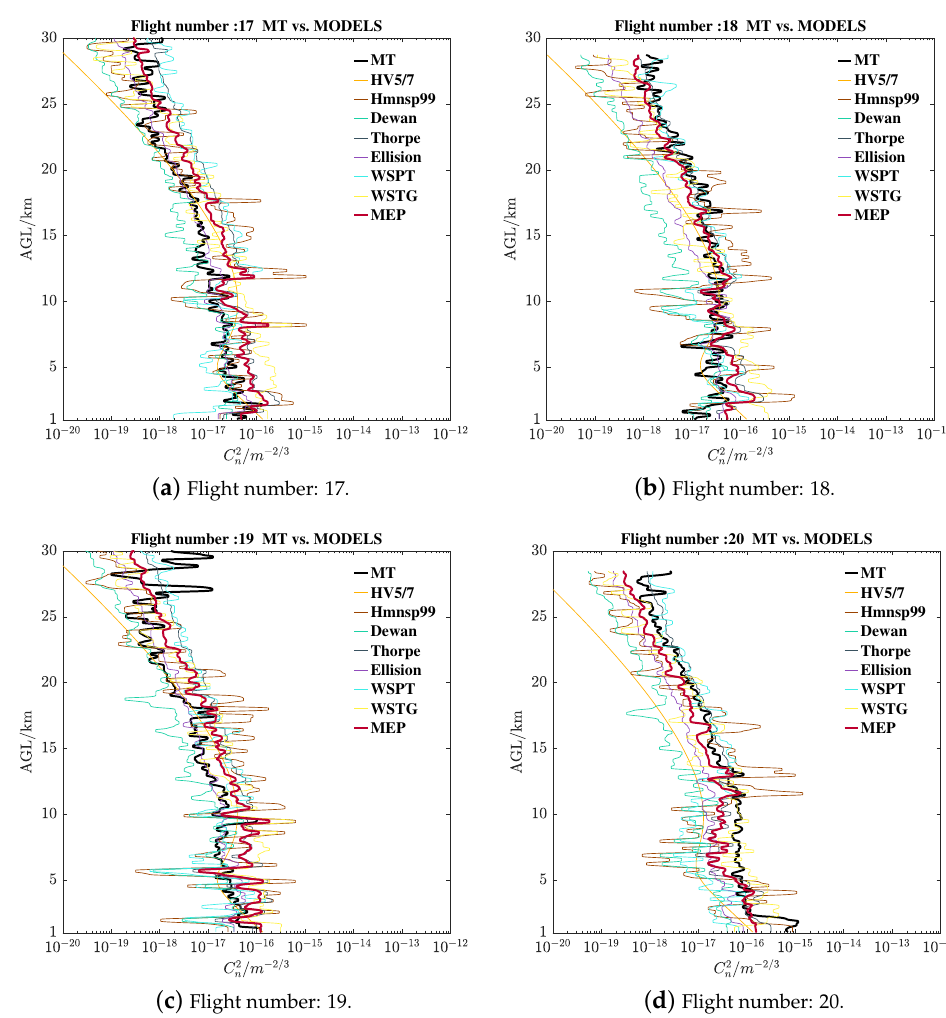
Figure A7. The refractive index structure parameter profiles of MT and estimations in NCACN: Figure A7 sub-figures ( a – d ) are flight numbers 17–20 in Table A2.